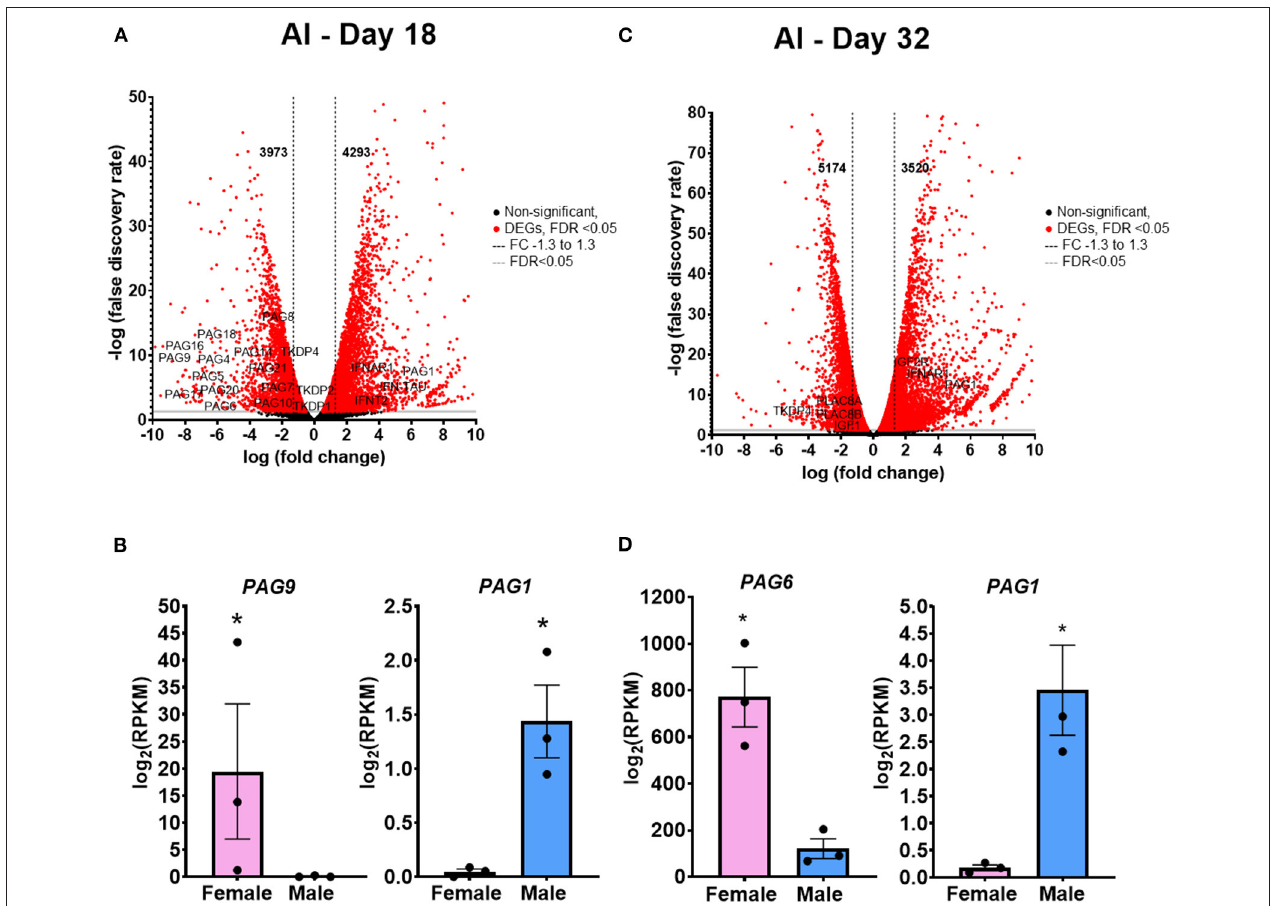
FIGURE 3 | Differentially expressed genes (DEGs) of the AI extraembryonic membranes comparing male vs female. (A) Volcano plot representing the number of DEGs comparing male vs female on day 18 conceptuses. Black dots are not significant (FDR > 0.05), Red dots are significant (FDR < 0.05), Gray line at FDR = 0.05, Black dashed lines delimit Fold Change (FC) − 1.3 to 1.3. (B) Representative genes upregulated in the female conceptuses ( PAG9 ) and in male conceptuses ( PAG1 ). (C) Volcano plot representing the number of DEGs comparing male vs female on day 32 conceptuses. Black dots are not significant (FDR > 0.05), Red dots are significant (FDR < 0.05), Gray line at FDR = 0.05, Black dashed lines delimit Fold Change at − 1.3 to 1.3. (D) Representative gene upregulated in the female conceptuses ( PAG6 ) and in the male conceptuses ( PAG1 ). *FDR < 0.05. AI, artificial